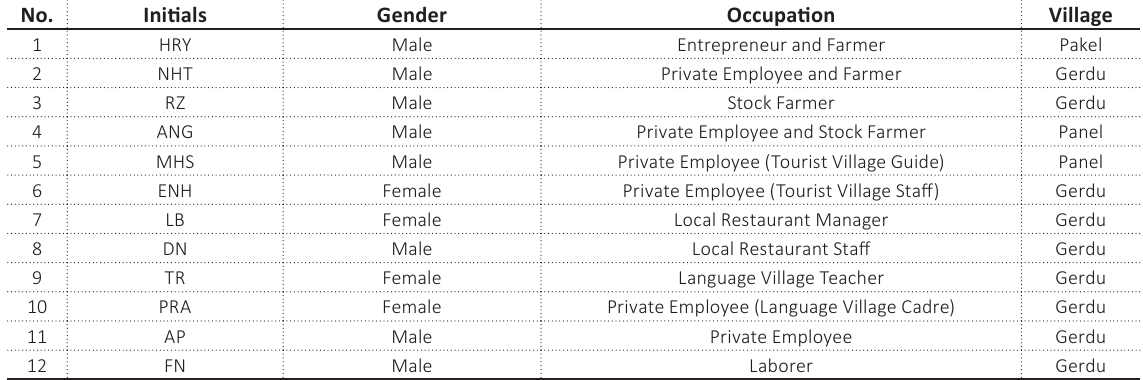
Table 2. List of informants related to the implementation model